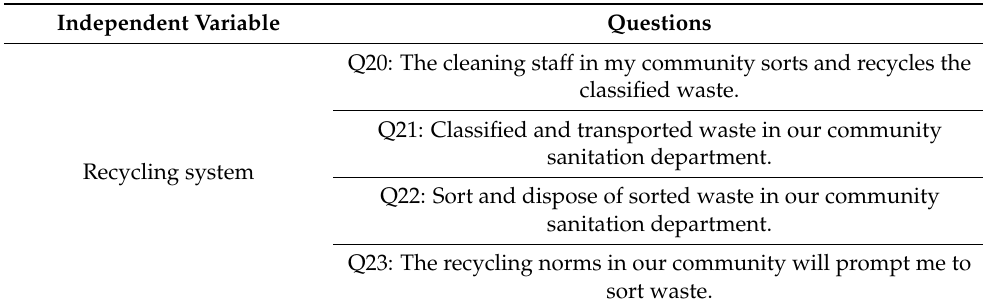
Table 5. Recycling system